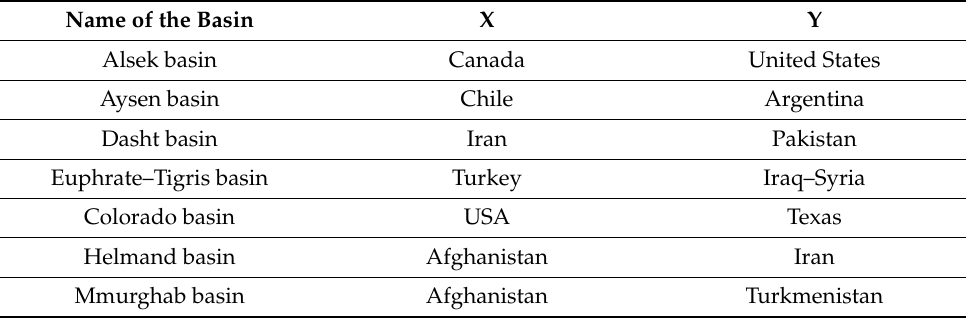
Table A1. Objective cases that can environmentally embrace HSA1.